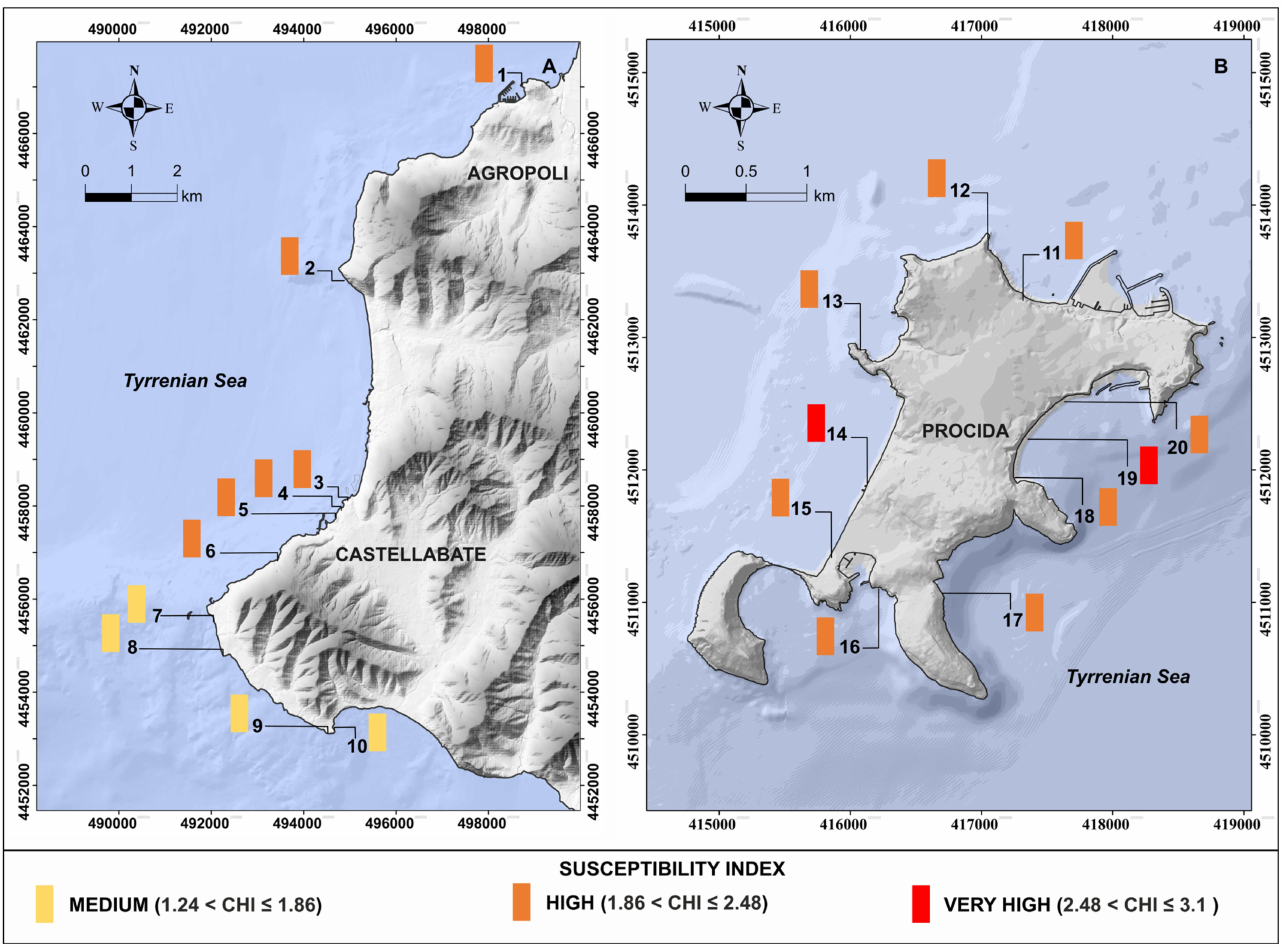
Figure 4. Susceptibility map of high coastal sectors along the Cilento area ( A ) and Procida area ( B ). Numbers indicate the study